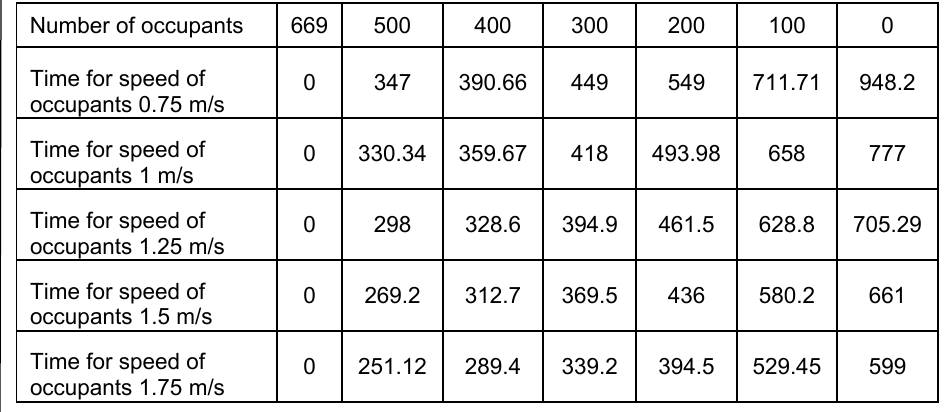
Table 21 – Simulation results in seconds for the third scenario, with elevators disabled and the second and the fourth entrances/exits blocked and for the occupants’